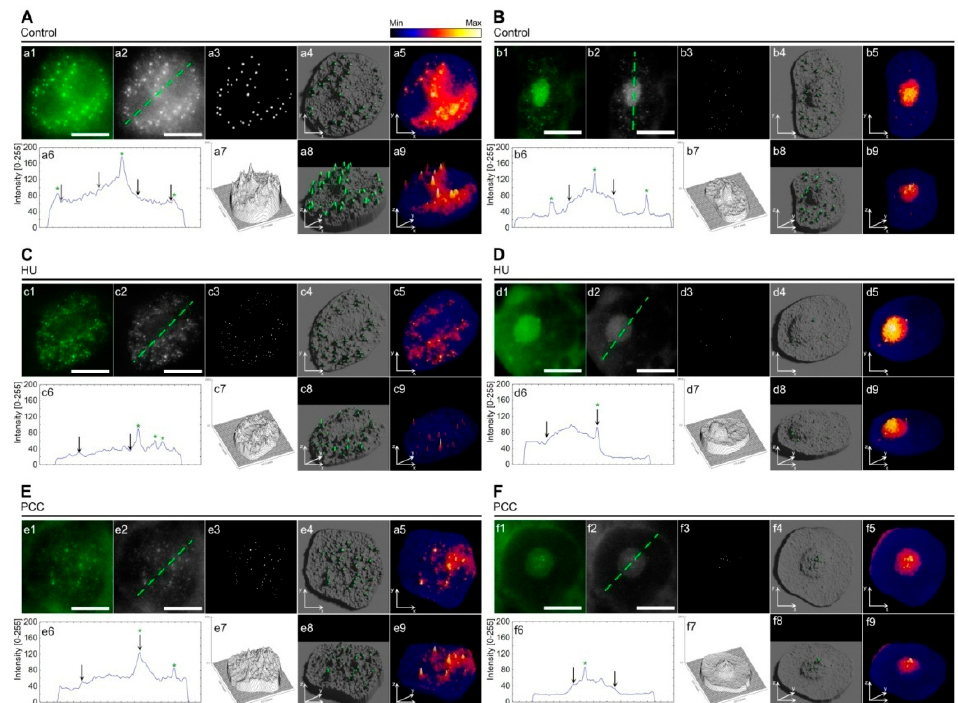
Figure 3. The descriptive analysis of different pRb foci localization depending on the visual morphology of nucleolus. The pRb activity within nuclei containing ‘dark’ nucleolus ( A , C , E ) is focused mostly in the other chromatin areas outside the nucleolus while the cells with ‘light’ nucleoli ( B , D , F ) show the activity of pRb also within the nucleoli itself or on the very border between the nucleolus and the rest of the nucleus (the perinucleolar heterochromatin). The green dashed lines at the grayscale images ( a2 , b2 , c2 , d2 , e2, and f2 ) mark the pathway used to prepare the line plots ( a6 , b6 , c6 , d6 , e6, and f6 ) that show the intensity (activity) of pRb at any given point along the line. The activity is shown in the same manner as described in Figure 1 (from 0 to 255), though the measurements are direct and not mean. The black arrows point to the nucleolus/nucleus borders, the green stars show the peaks corresponding to an active foci. The binary images ( a3 , b3 , c3 , d3 , e3, and f3 ) display only the most active areas of pRb within the nucleus. Images a7 , b7 , c7 , d7 , e7, and f7 are linear heightmaps generated in ImageJ based on the activity of the protein, where higher activity is shown as a peak or rise in height. The fourth column shows the 3D models based on the original images of analyzed nuclei. The grayscale activity images were used to generate the height-based mesh of the nucleus and the binary images were used to show only the active pRb foci. The last column shows the 3D models displaying the general luminescence of the analyzed nuclei in the form of heatmap, which uses the flame—like gradient to show the levels of lightness. The gradient ranges from black (no luminescence) through blue, purple, red, orange (increasing luminescence) ending at yellow and white (maximum luminescence). Both models allow to easily compare the general level of activity (5th column) with the localization of specific pRb foci (4th column). 3D models are shown as a top view (images 4 and 5 in each part from A to F) and rotated by 45 ◦ along X axis (according to the software’s coordinates). 3D models were generated in Blender 2.9.1. and based on original, unedited data. The scale bar is approx. 10 µ